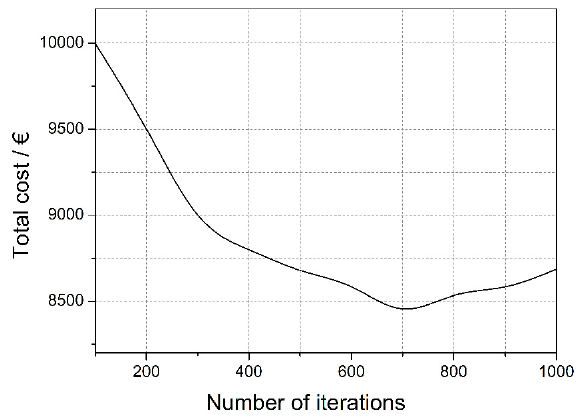
Figure 4. Program iteration diagram.